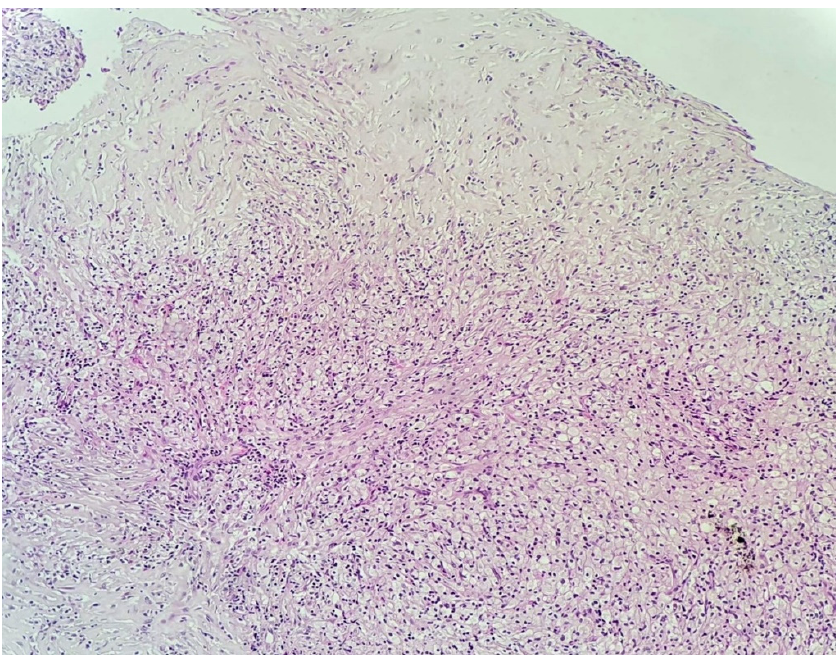
Figure 4. HE stain, 10× lens. Foamy macrophages predominantly centrally located. Numerous loose collagen fibers are present throughout the specimen, with more located toward the periphery .